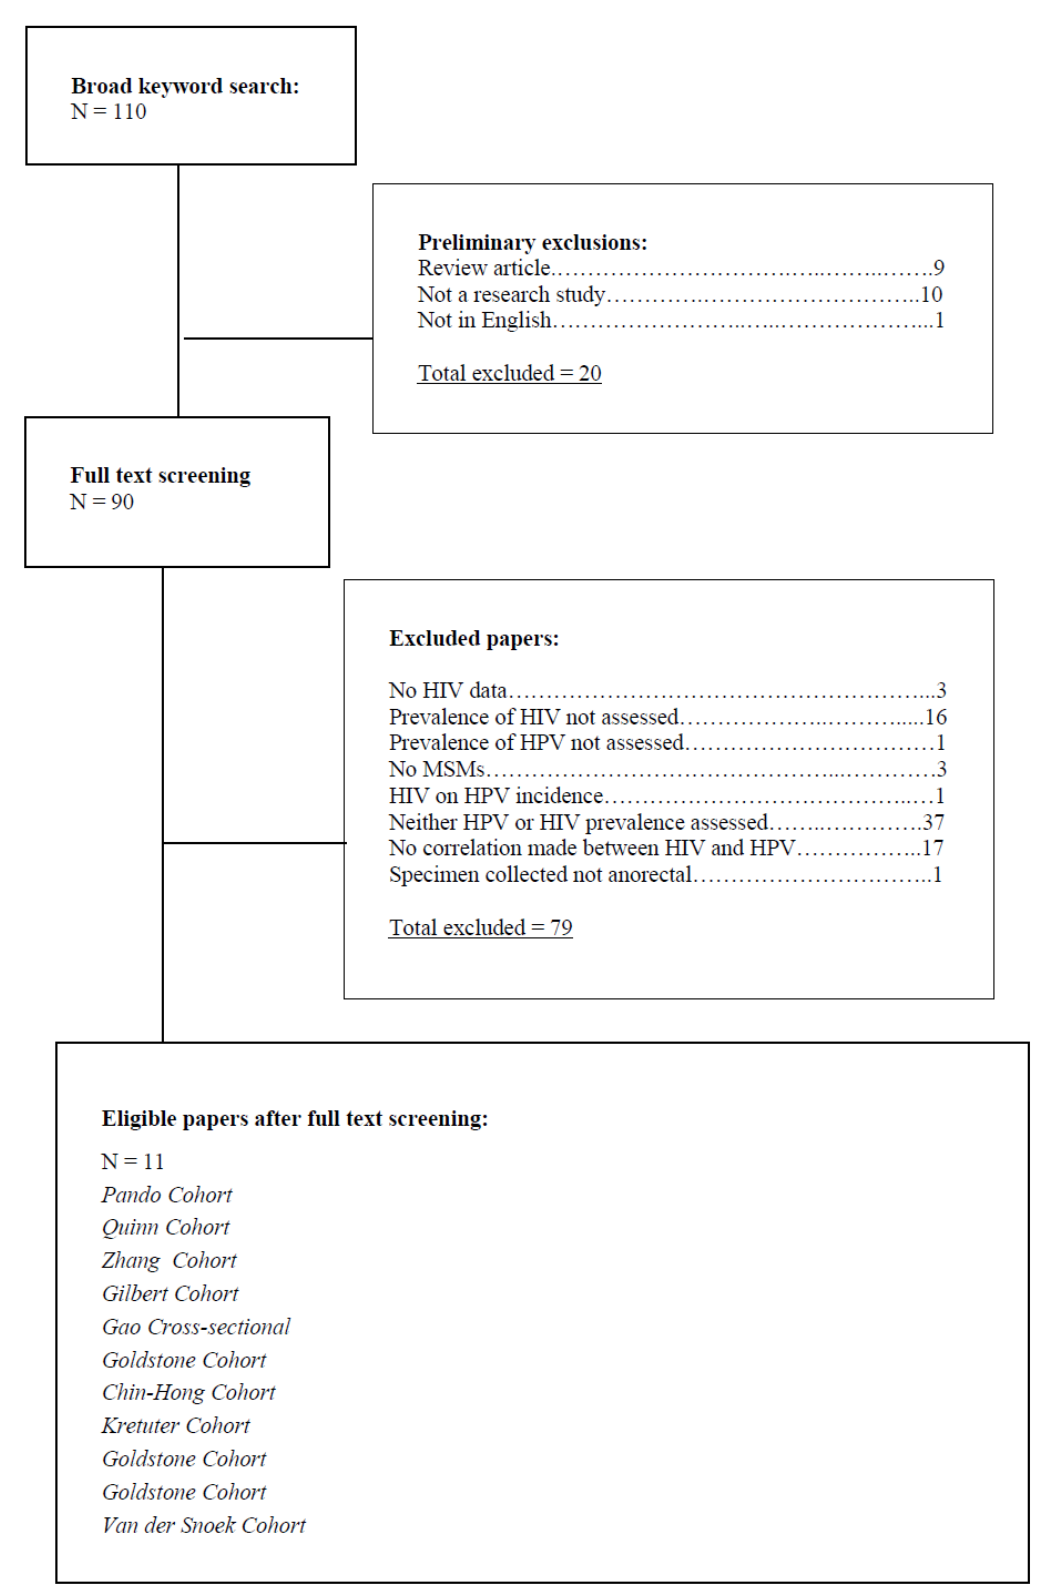
Figure 1. Human Immunodeficiency Virus (HIV) Human Papillomavirus (HPV) flowchart of